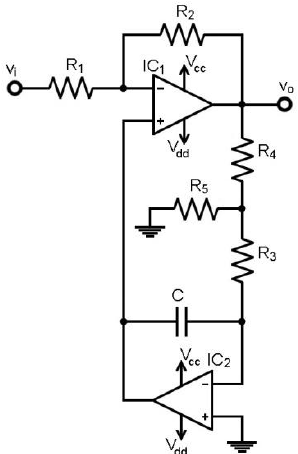
Figure 3. Proposed design for the high-pass filter with gain using a T-resistor network in the feedback.